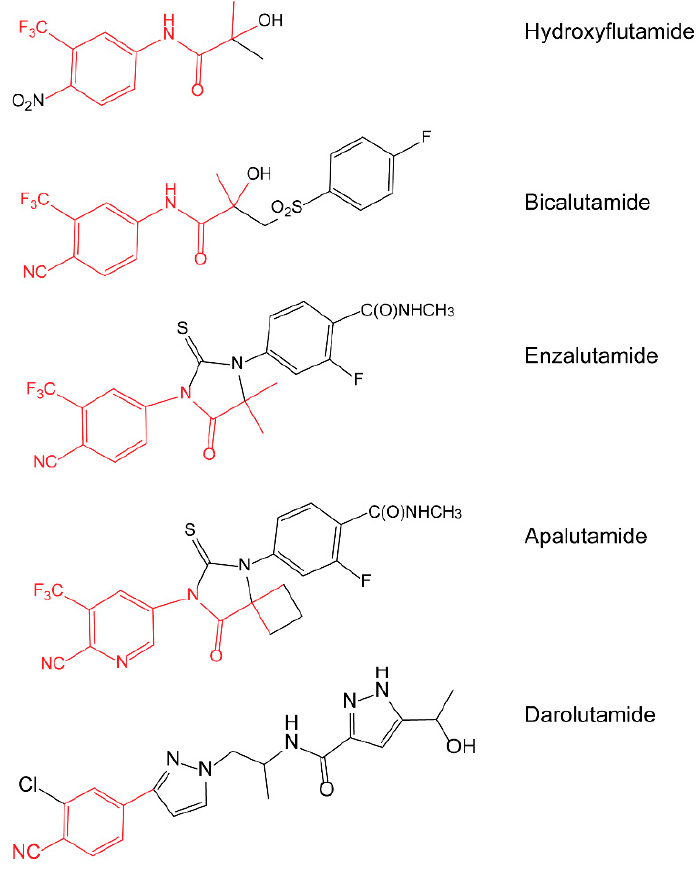
Figure 1. Chemical structures of clinically used AR antagonists.